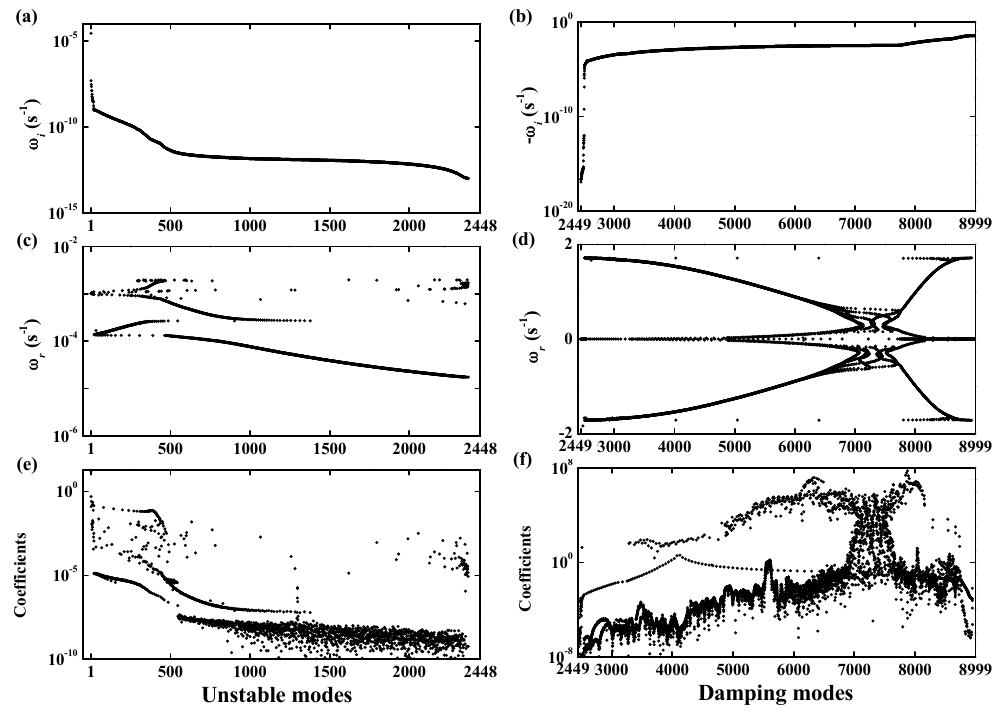
Figure 4. The unstable modes and the damping modes at WN 2, correspond to the scatterplots of ( a ); ( b ) growth rate, ( c , d ) eigenfrequency and ( e , f ) the absolute values of weight coefficients. Based on distributions of the coefficients for all eigenmodes (Figure 4e,f), it is apparent that there exist distinct differences ranging from 10 − 9 to 10 5 in coefficient magnitudes among these eigenmodes.